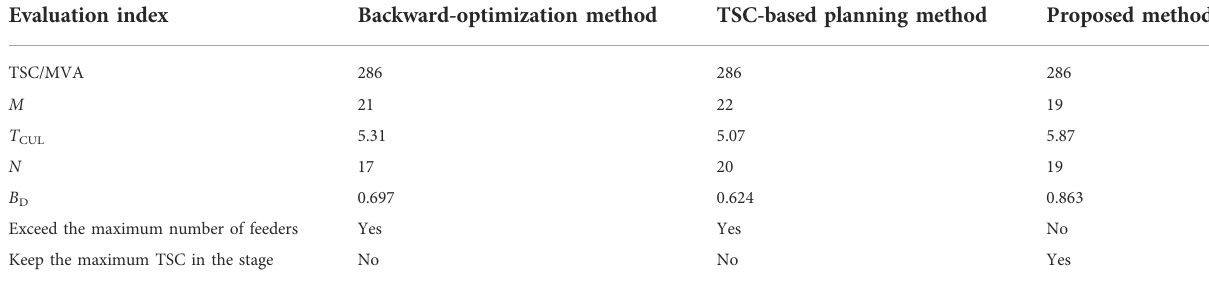
TABLE 5 Comparison of traditional methods and the proposed